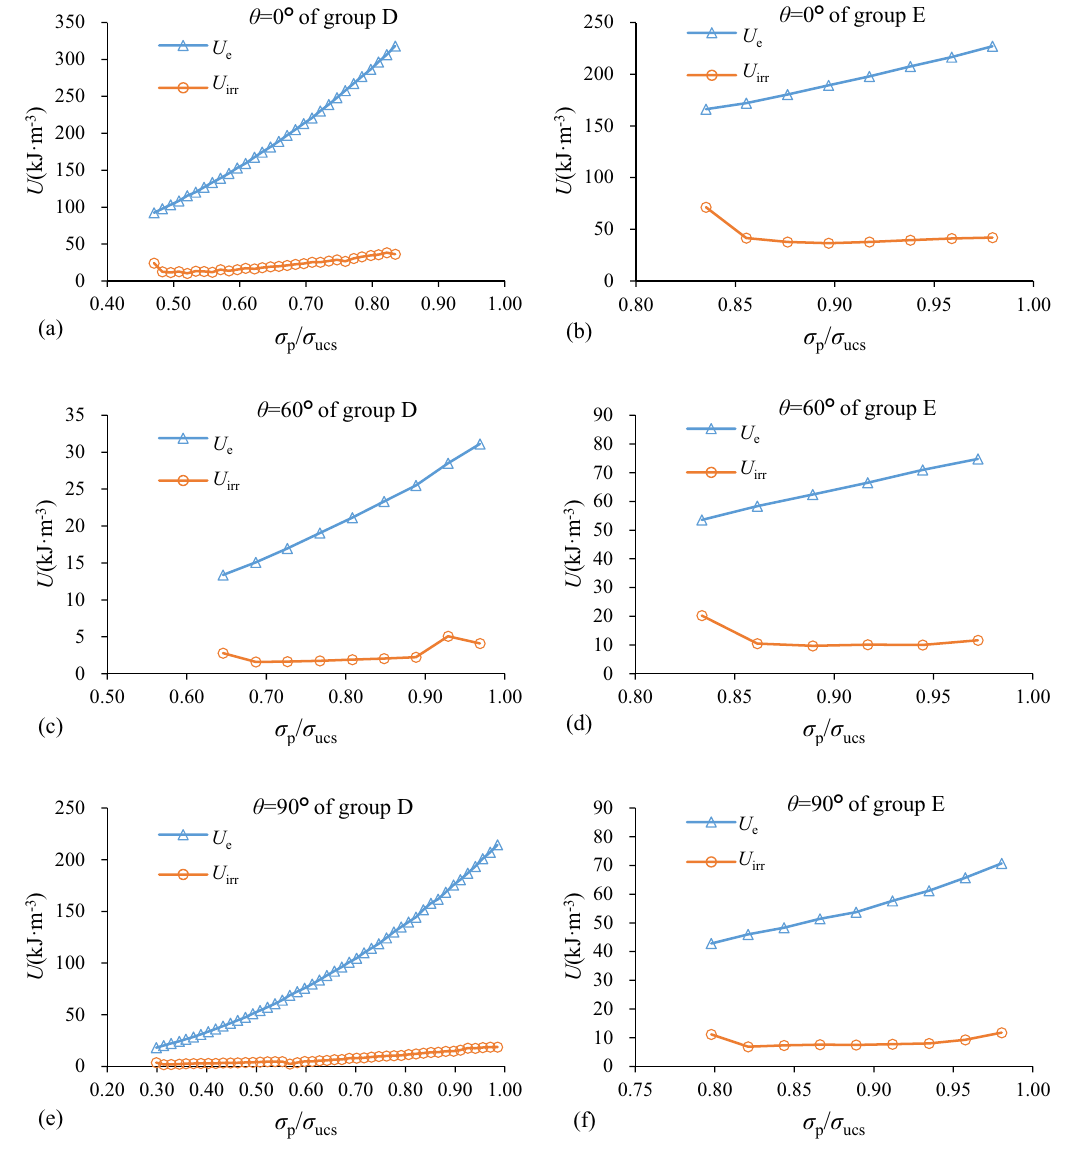
Figure 9. Evolution of U e and U irr of shale specimens of two groups with different dip angles as σ p / σ ucs in ascending order: ( a ) θ = 0° of group D; ( b ) θ = 0° of group E; ( c ) θ = 60° of group D; ( d ) θ = 60° of group E; ( e ) θ = 90° of group D; ( f ) θ = 90° of group